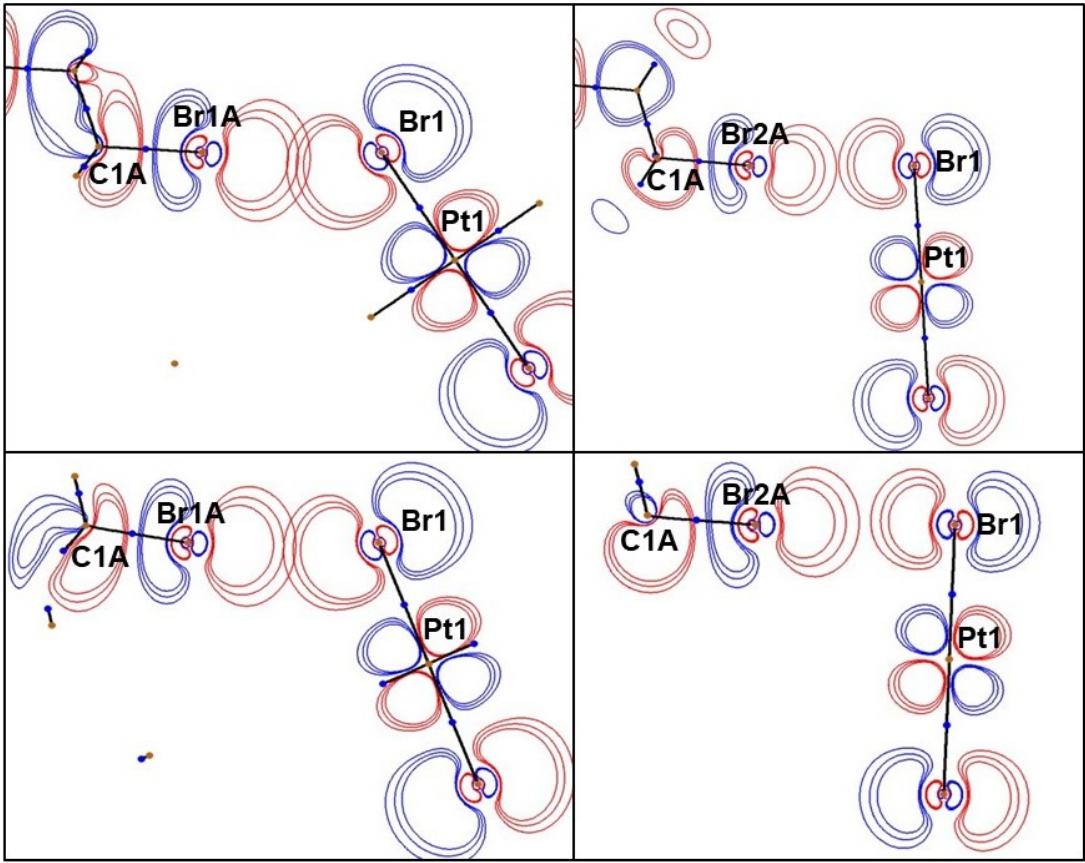
Figure 6. HOMO-LUMO overlap projections for XBs Br1A···Br1 and Br2A···Br1 in 1· tbe ( top ) and in 2 · tbe ( bottom ).